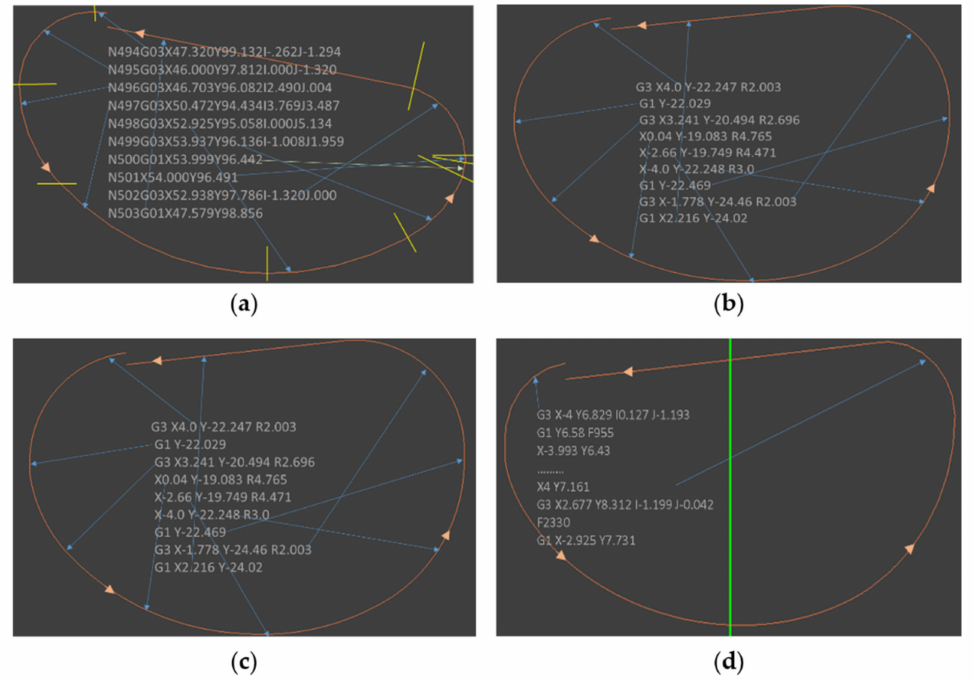
Figure 20. Four CAM trajectories